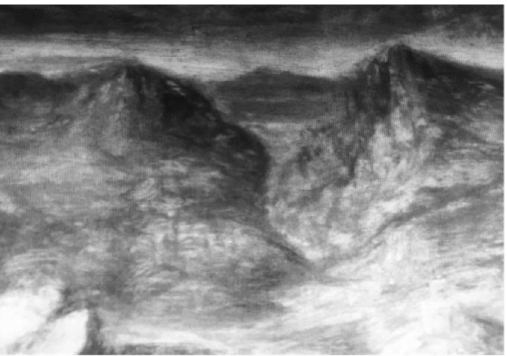
Figure 2. The date 1482 below the portrait of Dante in Leonardo’s Adoration of the Magi.